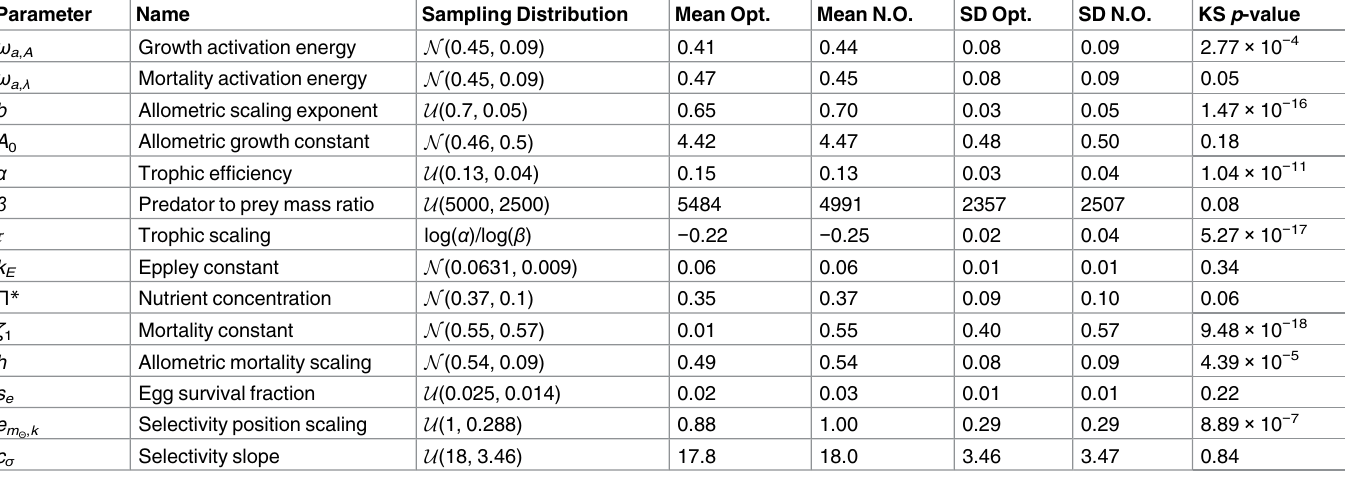
Table 3. Monte Carlo simulation parameter summaryresults. MC Distributionis the samplingdistributionof each parameter used in the Monte Carlo simu- lation, where X ( p 1 , p 2 ) represents the probabilitydistribution( N for normal, U for uniform), and p 1 and p 2 represent the mean and standarddeviationof the parameter, respectively. Opt. refers to the subset of optimizedMonte Carlo simulations, N.O. to the subset of non-optimized simulations, SD refers to the stan- dard deviation, and KS p -valueis the p -valueof the 2-sampleKolmogorov-Smirnov test appliedto the optimizedand non-optimized